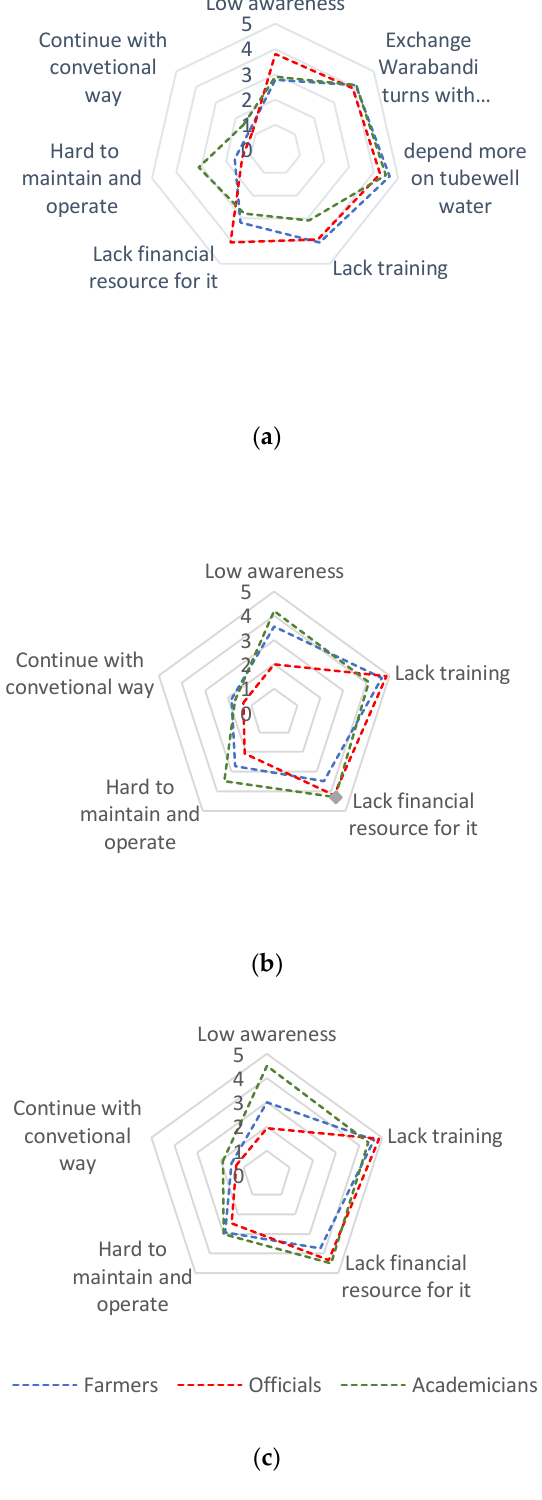
Figure 7. Perception comparison of three groups on barriers to ensuring the success of the adaptation process of ( a ) on-farm water storage facility ( b ) soil moisture sensors and ( c ) combination of a storage facility, soil moisture sensor and the drip method.